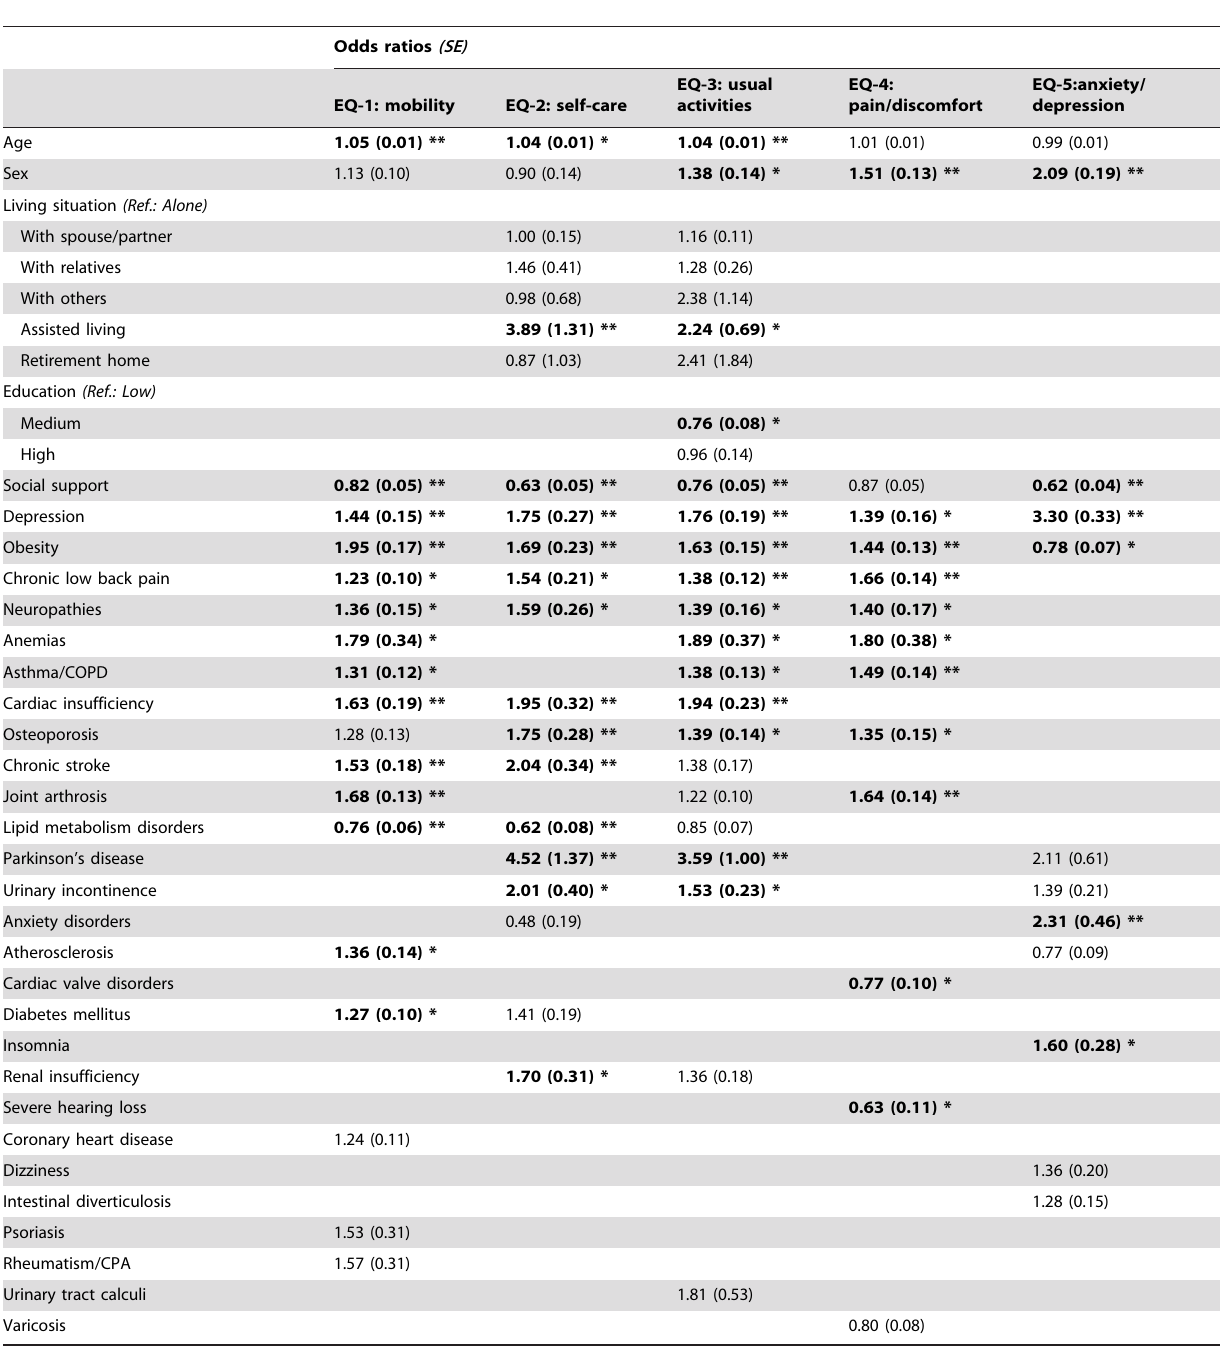
Table 6. Logistic regression models of the effect of individual conditions on separate EQ-5D dimensions.